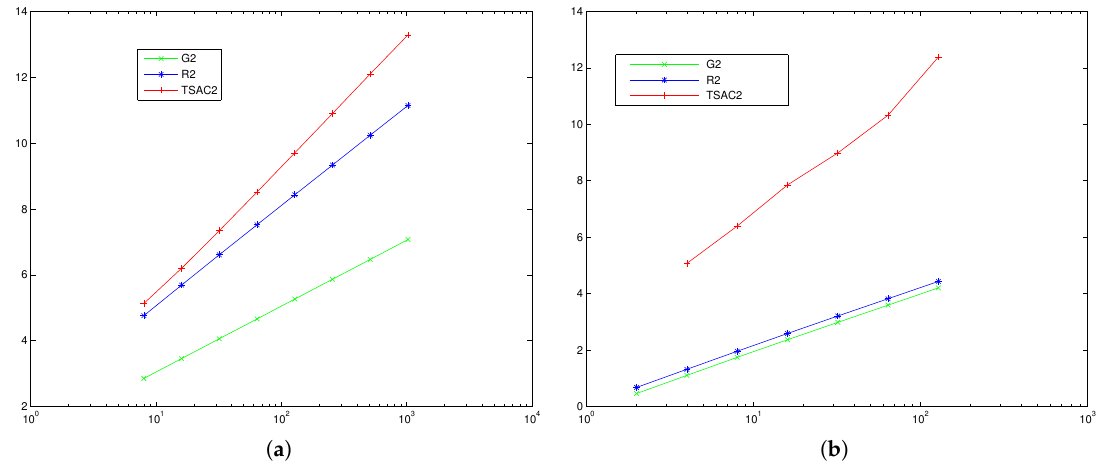
Figure 1. Number of correct significant digits with respect to the number of mesh points. ( a ) Problem (37); ( b ) Problem